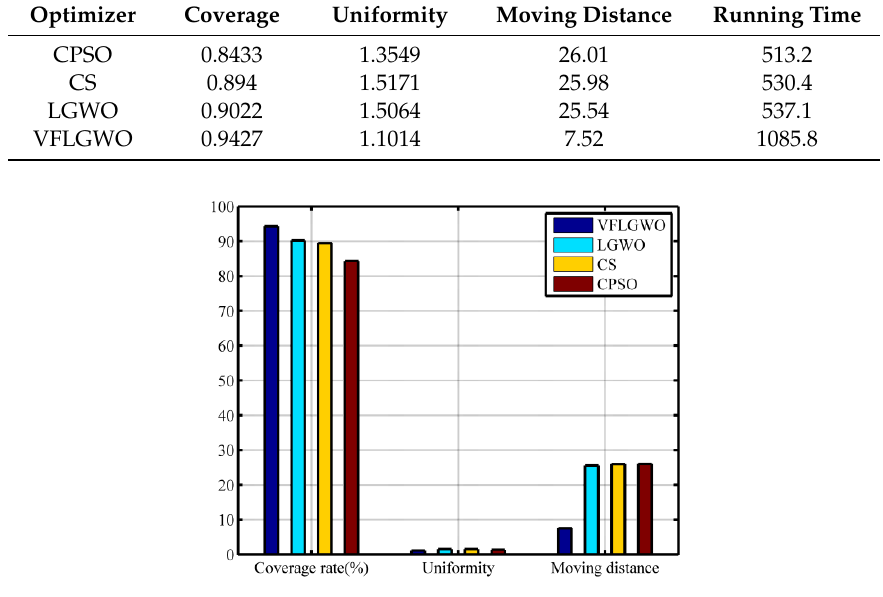
Figure 5. Comparison of the four algorithms.